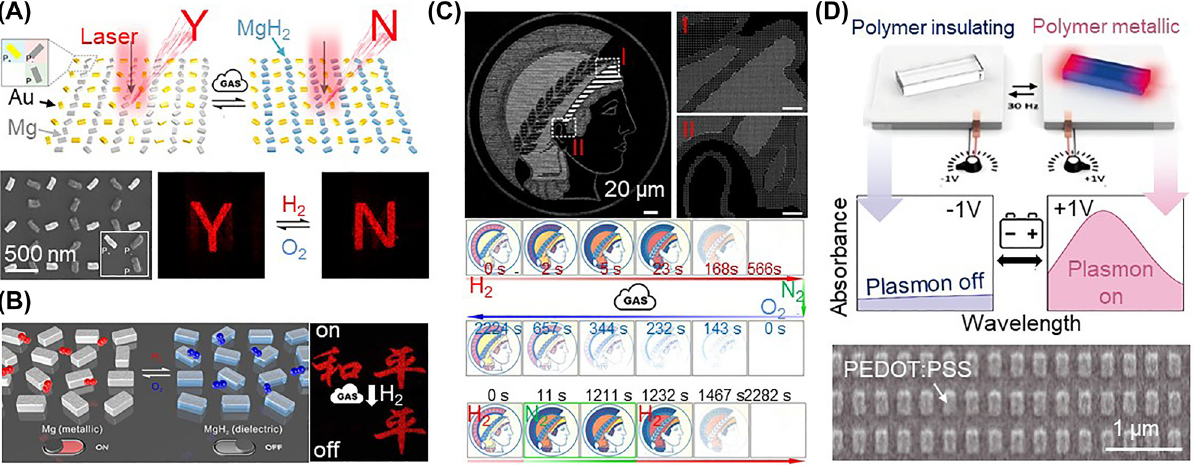
Figure 6: Responsive plasmonic nanopixels with the modulation of the real part of the dielectric constant Δ ϵ r of the nanoparticle: hydrogenation-driven phase change in the Mg nanostructures for (A – B) image change and on/off switching (produced with permission [78, 154], Copyright 2018, American Association for the Advancement of Science and 2018, American Chemical Society), and (C) color bleaching dynamics by gas reaction (reproduced with permission [155], Copyright 2017, Springer Nature). (D) electrochromic polymer nanopixels for plasmonic color dynamics by changing the redox states of the conductive polymer (reproduced with permission [153], Copyright 2021, American Association for the Advancement of